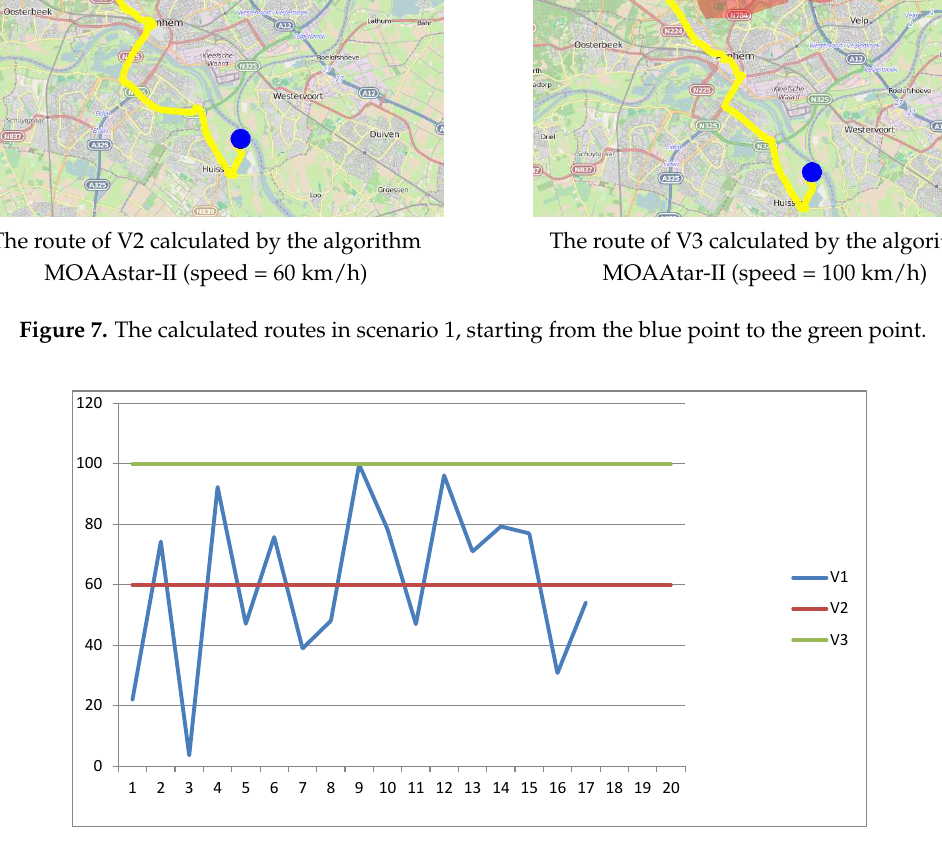
Figure 8. The speeds that the relief vehicles (V1, V2 and V3) should travel along their